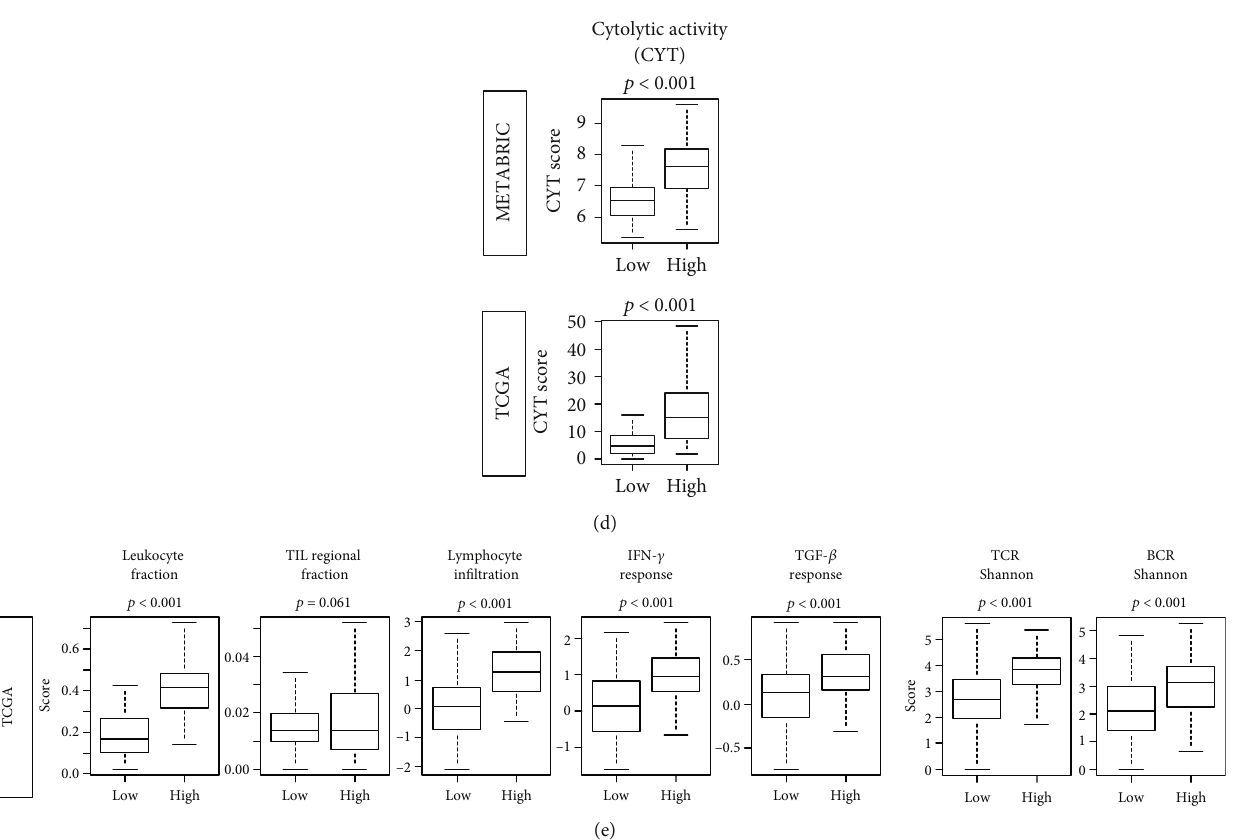
Figure 4: Composition of tumor in fi ltrating immune cells and immune function scores by high or low in fl ammatory scores in METABRIC and TCGA cohorts. (a) anticancerous immune cells including CD8 T cells, CD4 memory T cells, M1 macrophages, and dendritic cells (DC); (b) procancerous immune cells including regulatory T cells, Type 2 helper T cells (Th2), and M2 macrophages; and (c) B cells and plasma cells in the TCGA and METABRIC cohorts. Comparison of high vs. low in fl ammatory scores in (d) cytolytic activity score (CYT). (e) Leukocyte fraction, tumor in fi ltrating lymphocyte (TIL) regional fraction, lymphocyte in fi ltration, Interferon-gamma (IFN- γ ) response, T cell receptor (TCR) Shannon, TCR Richness, B cell receptor (BCR) Shannon, BCR Richness, and transforming growth factor-beta ( TGF - β ) response. In fl ammation score in each cohort were divided into low and high groups by the median value. Tukey-type boxplots show median